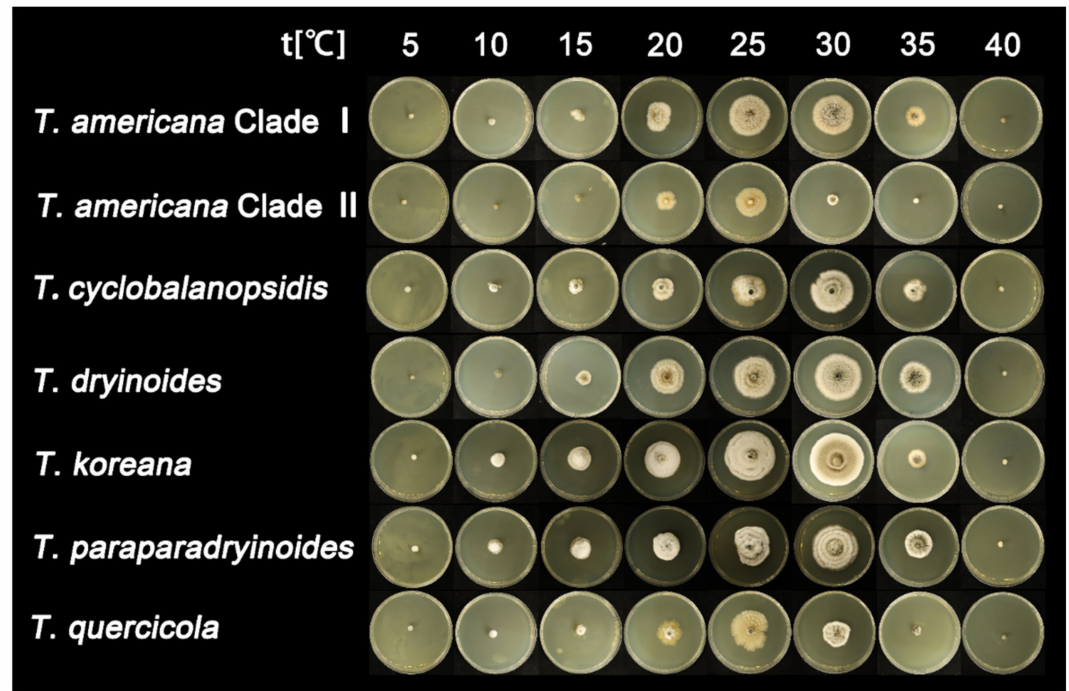
Figure 3. The effect of temperature on the mycelial growth rate of six Tubakia species on MEA after seven days of incubation.